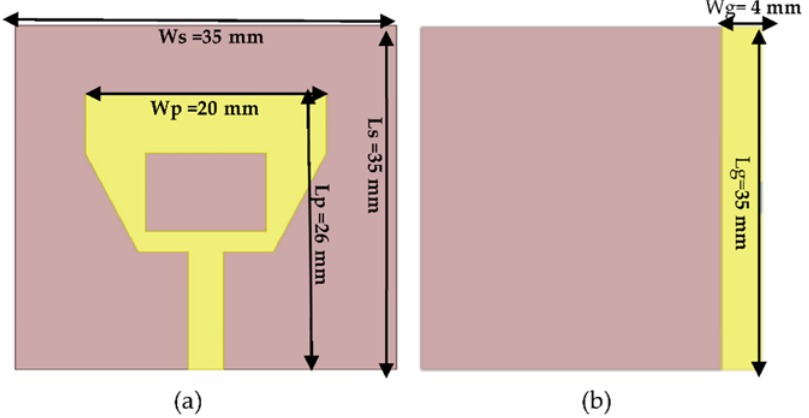
Figure 4. Designed flat patch antenna on epoxy flexible material: ( a ) front view and ( b ) bottom view.